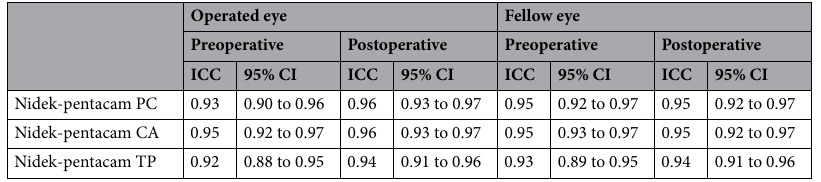
Table 2. ICC and 95% CI for operated and fellow eye. PC pupil center, CA corneal apex, TP thinnest point, ICC intraclass correlation coefficient, 95% CI 95% confidence interval.